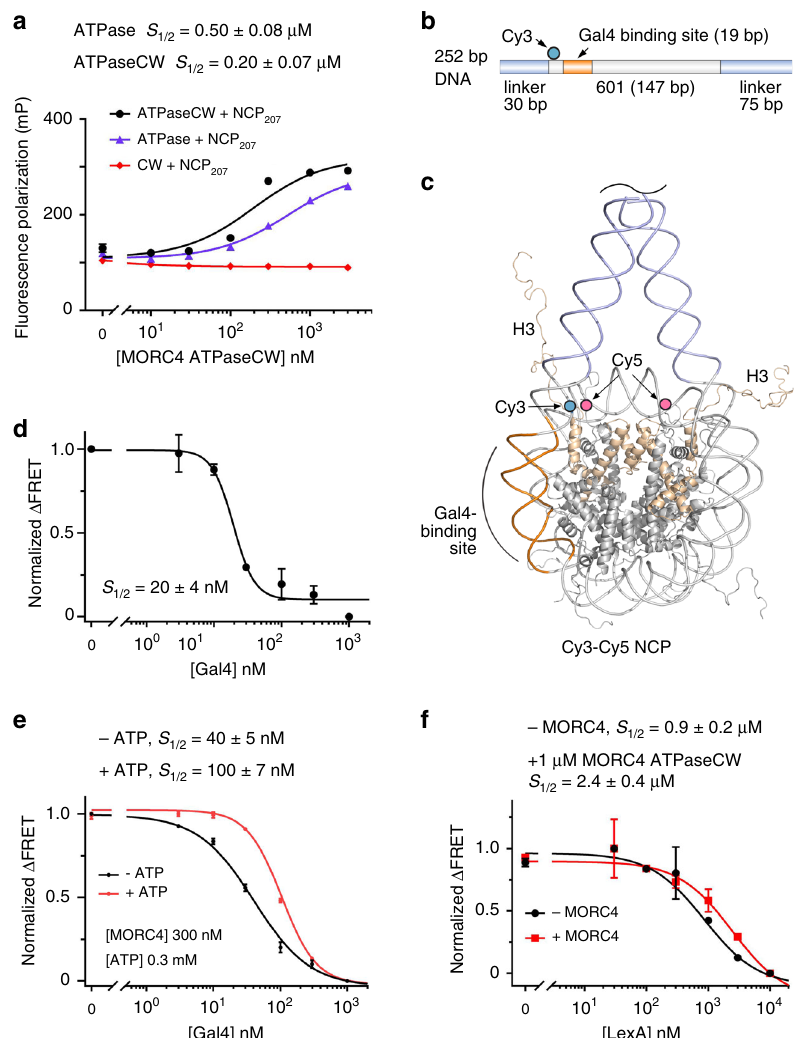
Fig. 6 MORC4 ATPaseCW binds to and stabilizes nucleosomes. a Binding af fi nities and binding curves for the interactions of the indicated MORC4 regions with NCP 207 as measured by fl uorescence polarization. Data are represented as mean values + / − S.D. from three independent experiments ( n = 3). b Schematic of the 252 bp DNA containing the 601 Widom sequence with a 75 bp linker at the 3 ′ end, a 30 bp linker at the 5 ′ end, and a Gal4 transcription factor binding site at bases 8 – 26 in the 601 Widom sequence with Cy3 positioned 34 bp from the 5 ′ end (cyan circle). c A model based on the crystal structure of the NCP with 197 bp palindromic 601 L DNA (PDB ID: 5NL0, the linker histone H1 is not shown) with histone H3 (wheat), Cy5 at H2AK119C (pink circles), Cy3 at the DNA (cyan circle), and the Gal4 target site (orange) are shown and labeled. Truncated DNA linkers are shown and colored light blue. d , e Normalized change in FRET ef fi ciency of the Cy3-Cy5 labeled NCP 252 upon addition of Gal4 in the absence ( d ) and presence ( e ) of MORC4 ATPaseCW and + / − ATP. Data are represented as mean values + / − S.D. from three independent experiments ( n = 3). f Normalized change in FRET ef fi ciency of the Cy3-Cy5 labeled NCP 147 upon the addition of LexA in the absence and presence of MORC4 ATPaseCW. Data are represented as mean values + / − S.D. from three independent experiments ( n =